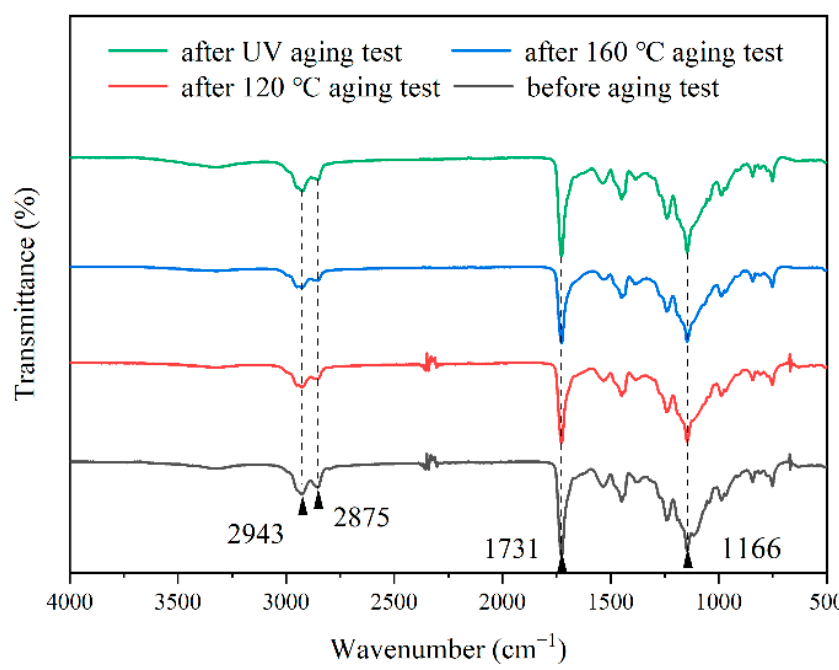
Figure 16. Infrared spectrogram of containing microcapsules before and after aging.